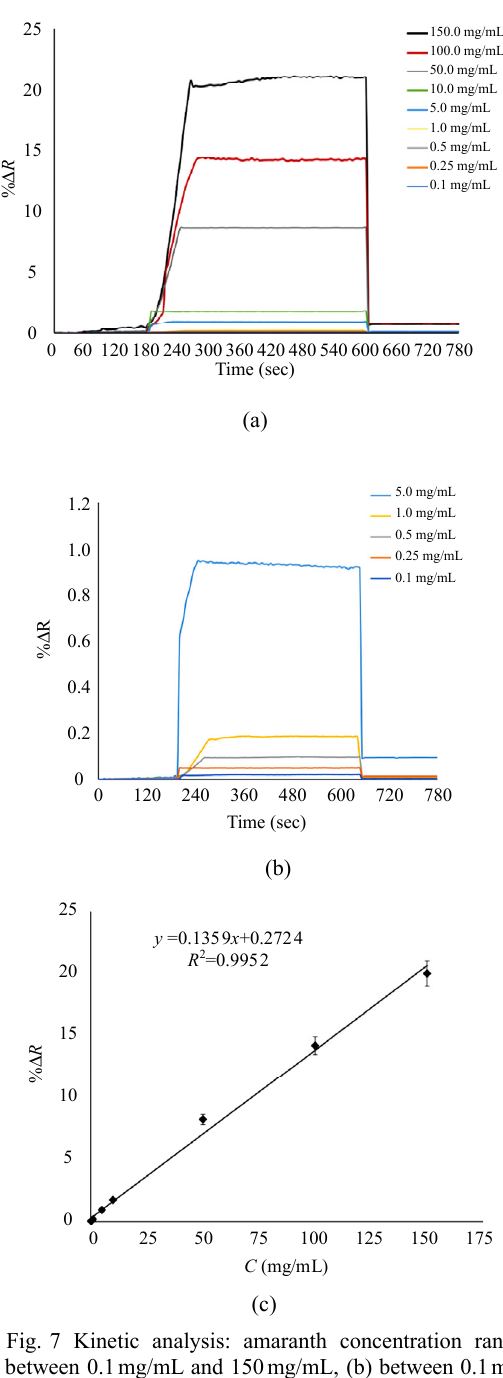
Fig. 7 Kinetic analysis: amaranth concentration range of (a) between 0.1 mg/mL and 150 mg/mL, (b) between 0.1 mg/mL and 5 mg/mL, and linear regions (c) of the amaranth imprinted SPR sensor aqueous solutions of amaranth at different